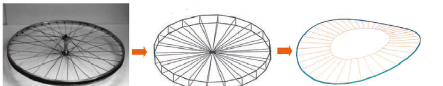
Figure 1: The evolution process of spoke single-layer cable net.